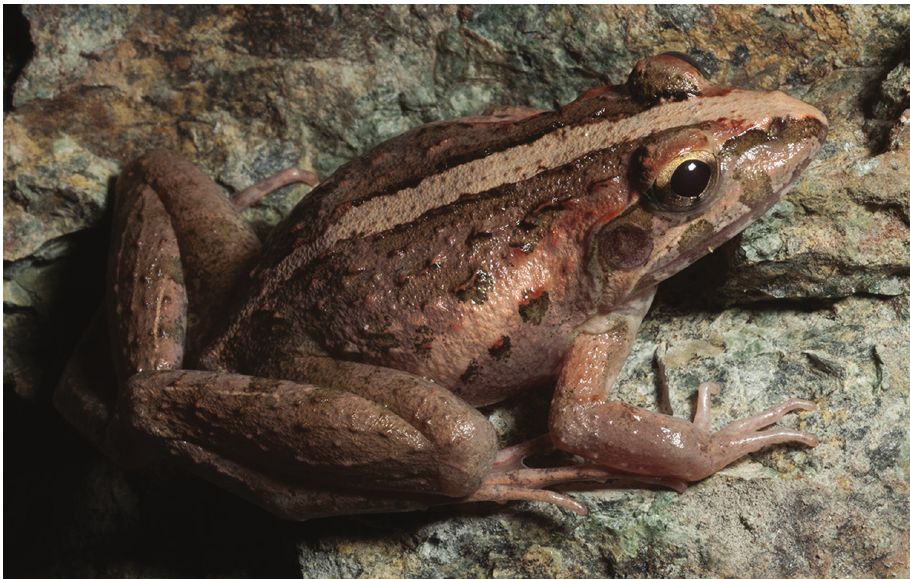
Figure 12. Fejervarya vittigera has been observed in coastal and inland low elevation areas throughout northeast Mindanao. Photo (RMB; deposited at KU; specimen not yet cataloged) from the Municipality of Burauen, Leyte Island.